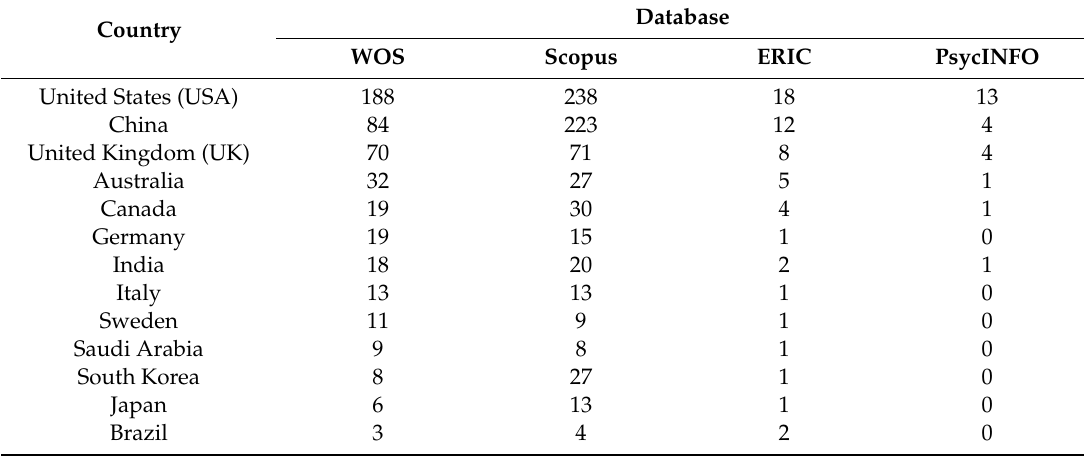
Table 3. Countries with the highest scientific production in WOS, Scopus, ERIC, and PsycINFO. Database Country WOS Scopus ERIC PsycINFO 188